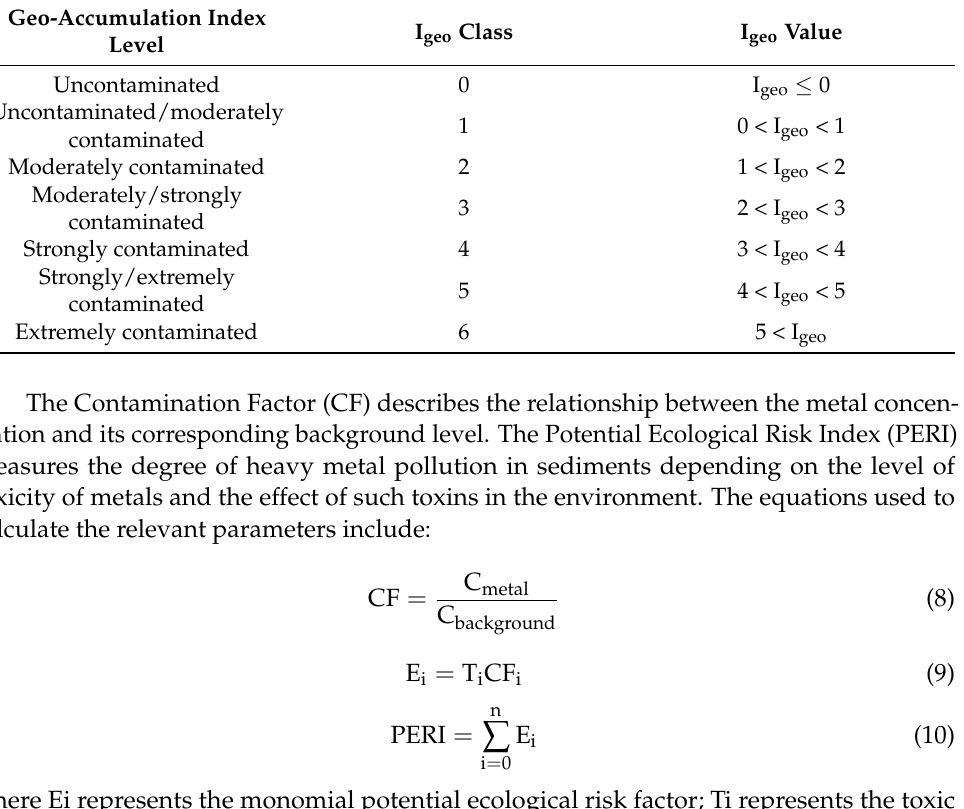
Table 4. Classification of geo-accumulation index (I geo ) [32].